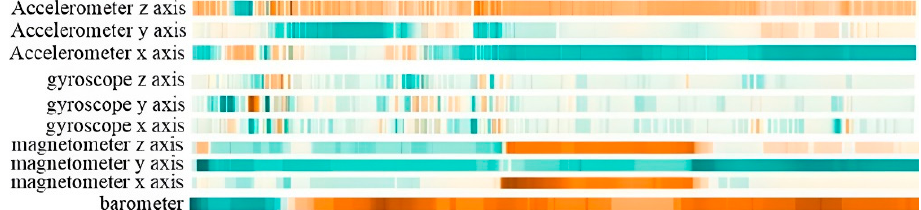
Figure 3. The time series data collected by